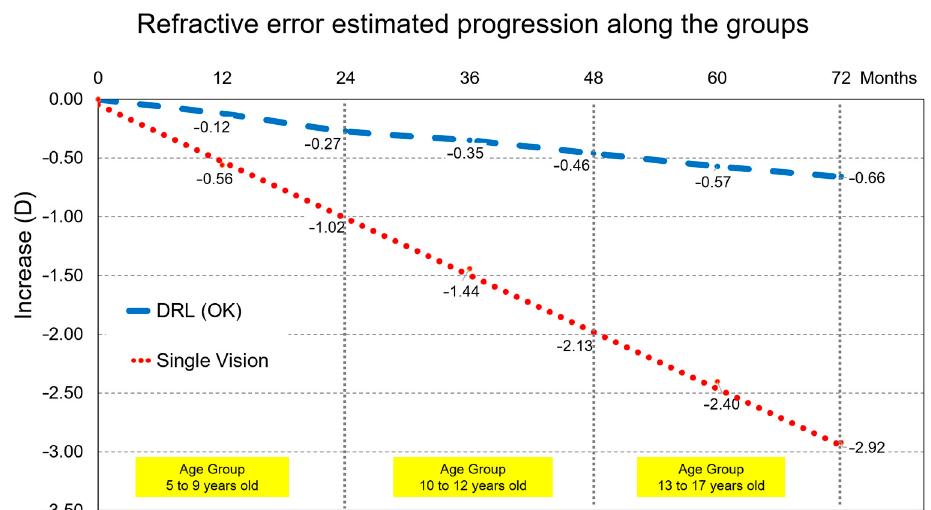
Figure 4. Myopia progression for all participants linking the end and the beginning of each age group. Even not being same individuals, an overall trend may be inferred for both groups. Thus, a projected different M component change by − 2.26 D after 6 years for a child starting myopia at 8 years compared to wearing orthokeratology lenses or single vision lenses. This accounts for a 3-fold increase risk in macular degeneration or retinal detachment.